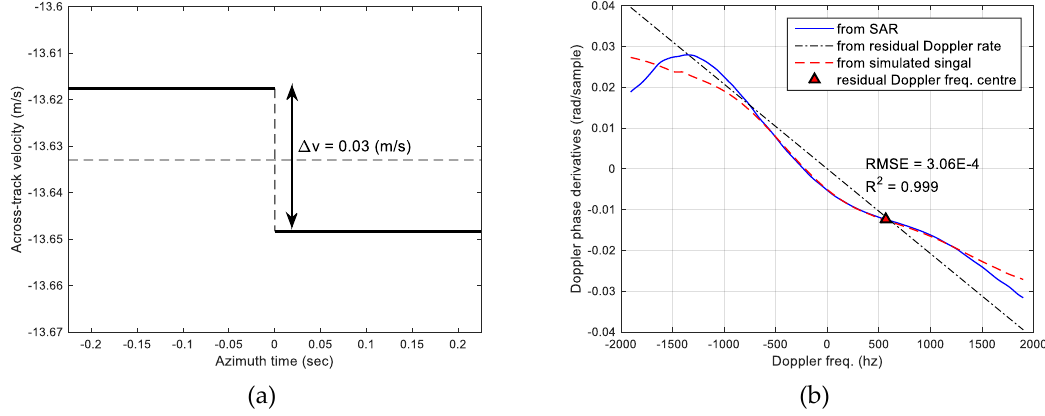
Figure 4. Comparison between the actual SAR observation of vehicle 1 and a simulated signal. ( a ) A discontinuous velocity jump model with a velocity increase of 0.03 m/s in the negative direction (i.e., increased approach velocity to the antenna). ( b ) Doppler phase derivatives of SAR SLC data (blue) and a simulated result based on the velocity variation model of ( a ). A velocity was simulated as a negative increase from –13.618 m / s to –13.648 m / s over a period of 0.45 s. The Doppler rates of K a = 5438.1 (Hz / s) and ∆ K = − 11.20 (Hz / s) were used for the simulation. The correlation between the results of the actual SAR data and the simulation was 0.999 with a root-mean-square error of 3.06 × 10 − 4 . All parameters used for the simulation were derived from the velocities and accelerations estimated by the method proposed in this paper.